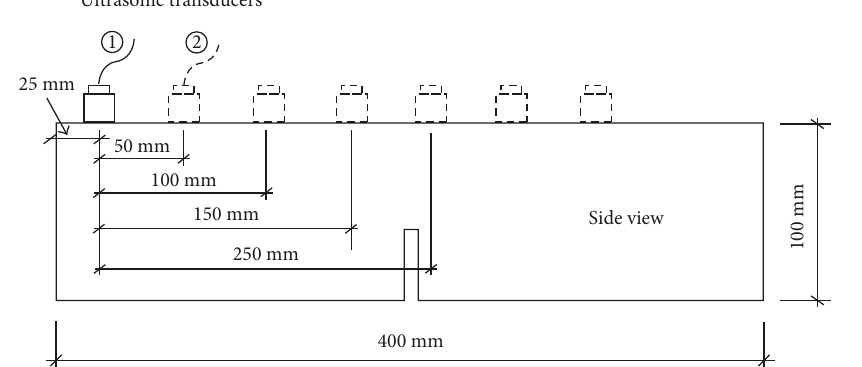
Figure 9: Diagram of the ultrasonic single side test method.